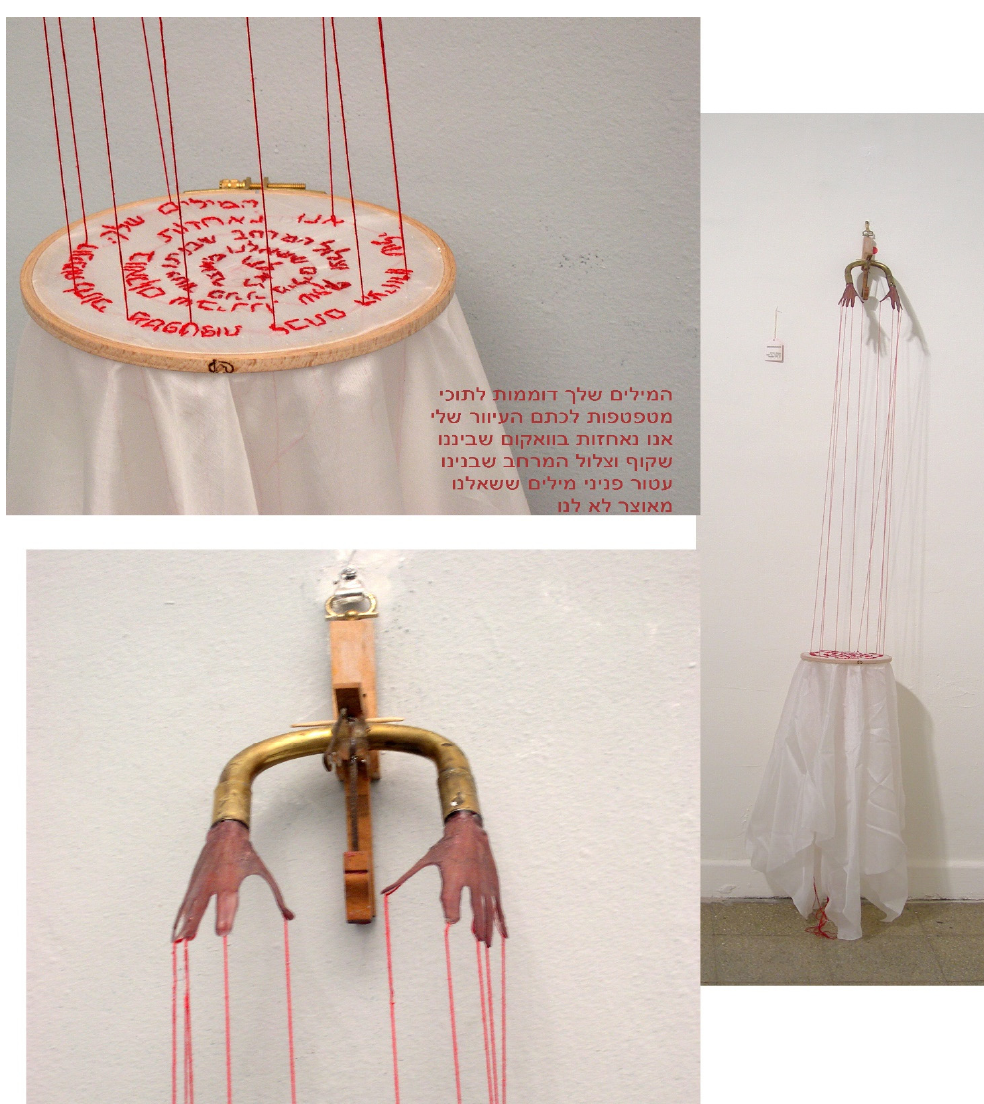
Figure 7. Dvora Morag, “To My Daughter”, 2006. Mixed Media. Photo: Avi Amsalem.